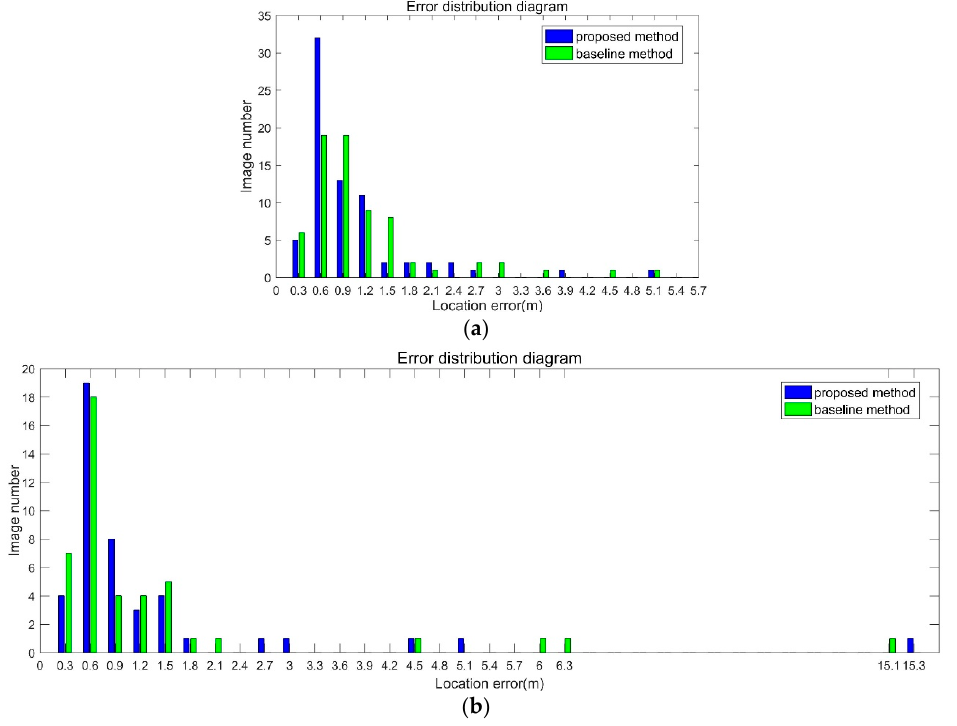
Figure 11. The location error distribution diagram of dataset 1. ( a ) Samsung dataset result. ( b ) iPhone dataset result.